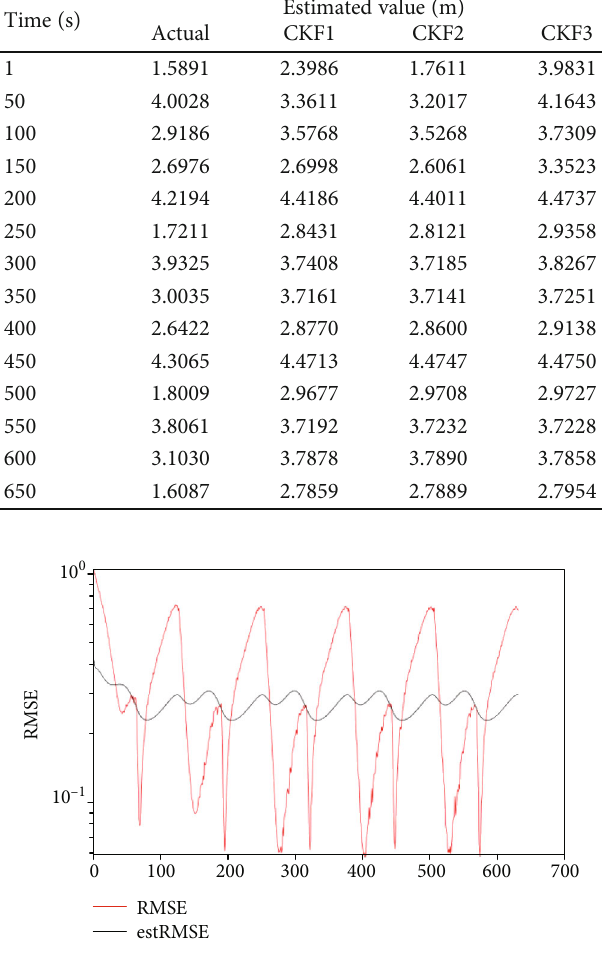
Figure 6: State estimation results after optimization of stochastic disturbance state estimation.